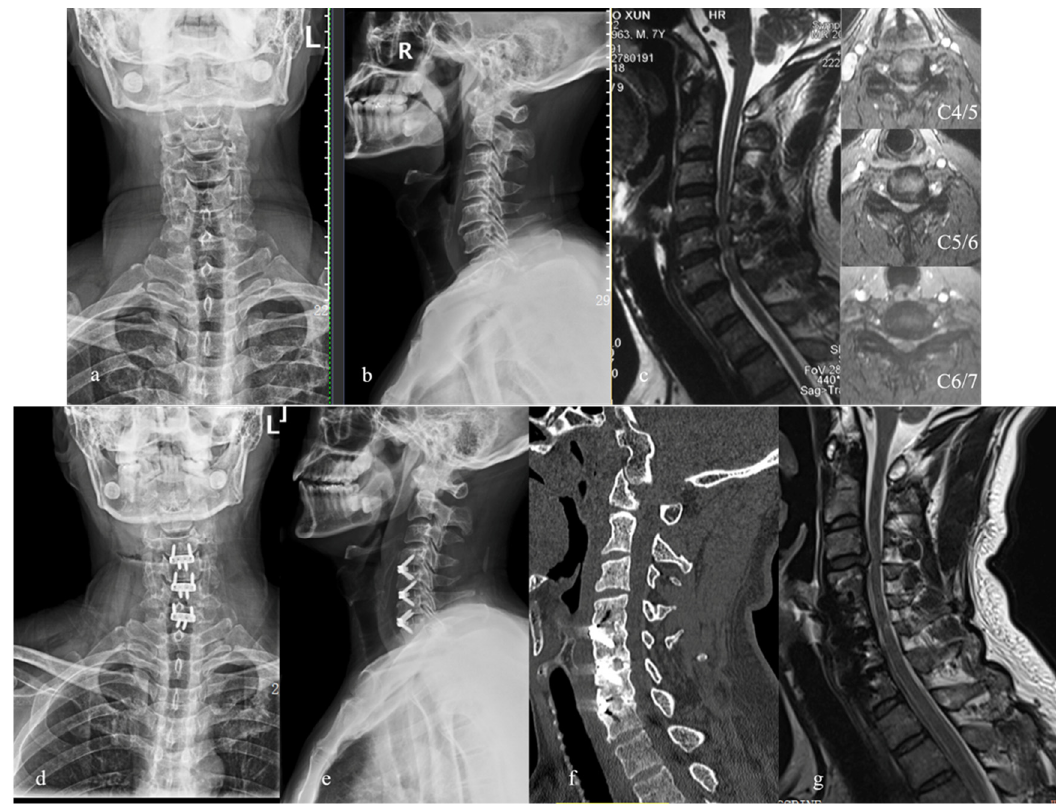
Figure 1. A 54-year-old male with walking disturbance and clumsy hands for 5 years and radiating pain in the left arm for 6 months. ( a , b ) Preoperative x-ray films; ( c ) preoperative MRI showing C4-C7 disc herniation compressing the spinal cord, and stenosis on the left nerve root canals; ( d , e ) postoperative X-ray films showing C4-C7 ACDF with Zero-P spacers; ( f ) CT scan at 2-year follow-up showing good implant position and bone fusion; ( g ) MRI at 2-year follow-up showing ASD at C3/4; however, there was no complaint of any symptoms and observation was implemented.